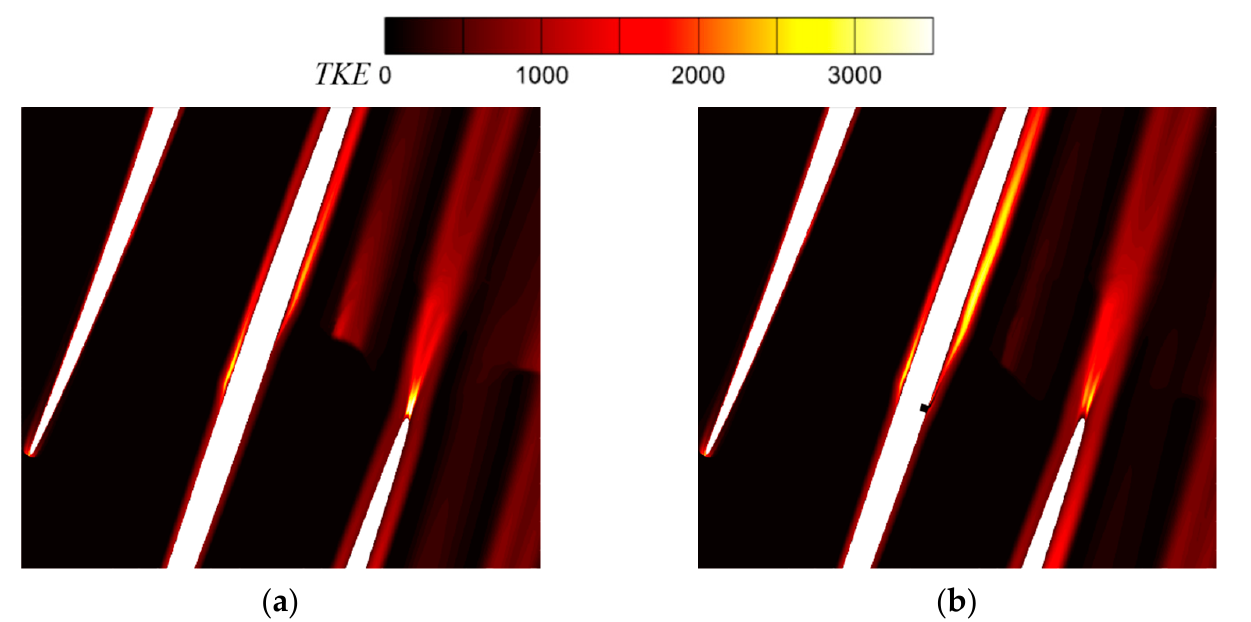
Figure 7. Turbulent kinetic energy contours for baseline and controlled cases: ( a ) baseline case; ( b ) controlled case.